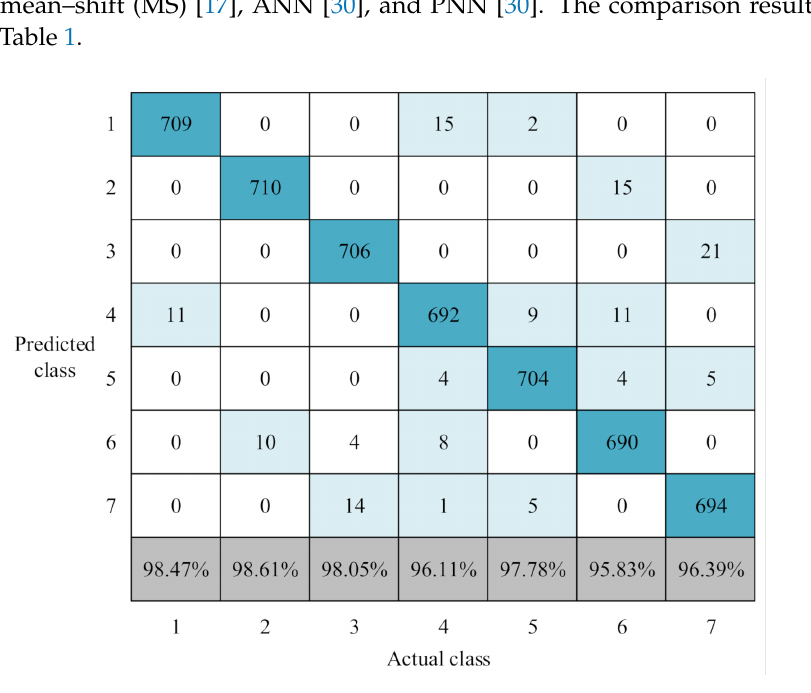
Figure 14. Fault diagnosis result with noise data based on the